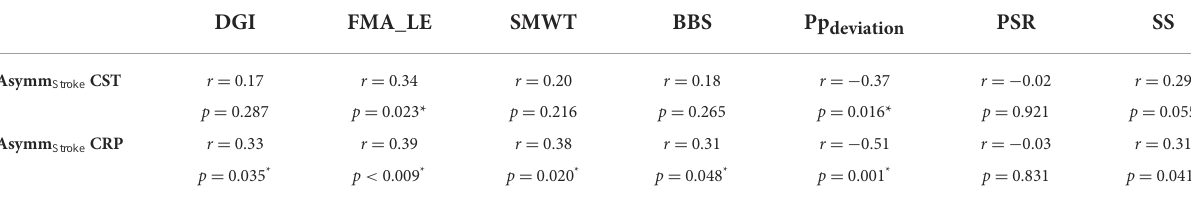
TABLE 2 Correlations of motor pathways with biomechanical and clinical